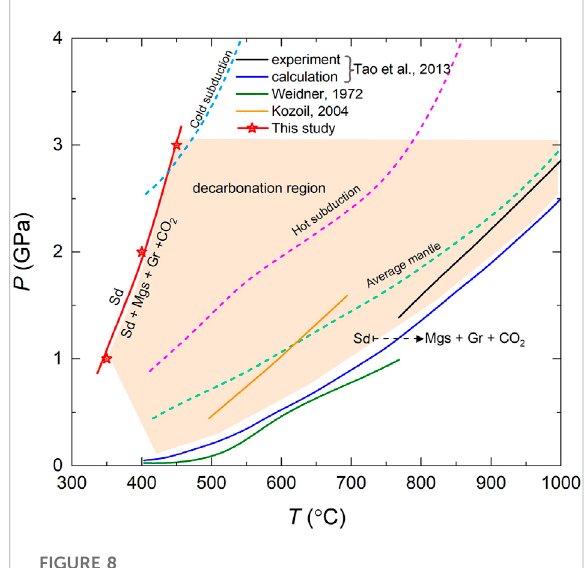
FIGURE 8 The incipient decomposition temperature of siderite = magnetite + graphite + CO 2 determined in this study, along with previous phase boundary results from phase equilibrium experiments and thermodynamically calculation. The thermal structures of deduction slab in typical hot and cool subduction zones and average mantle geotherm indicated as dashed lines from Syracuse et al. (2010) and Akaogi et al.